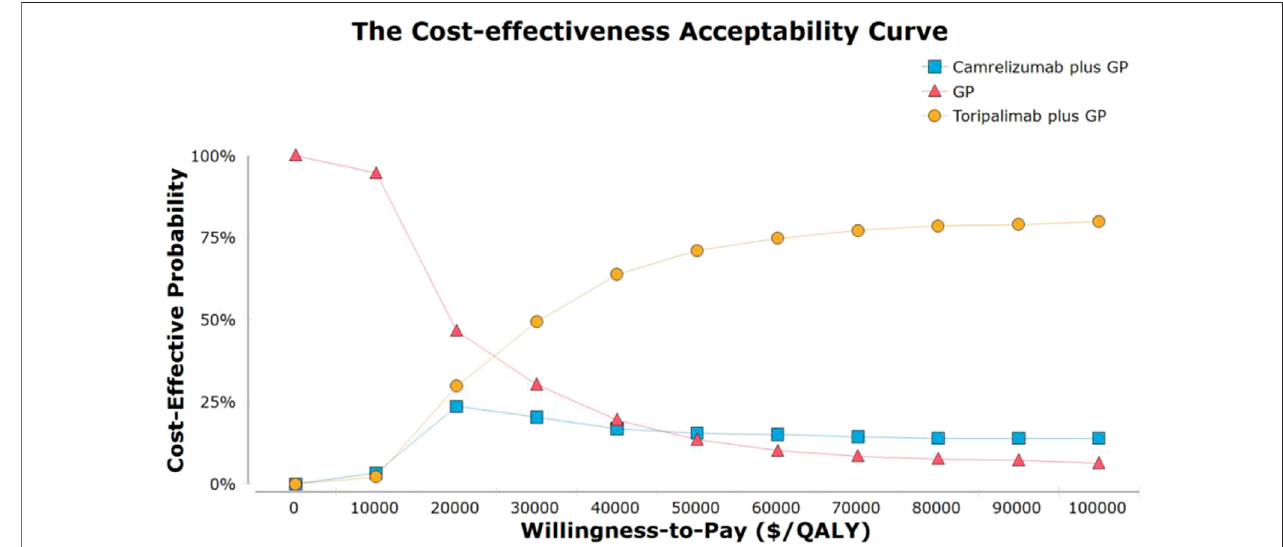
FIGURE 2 | The cost-effectiveness acceptability curves for the toripalimab plus gemcitabine and cisplatin, camrelizumab plus gemcitabine and cisplatin. Abbreviation: GP, gemcitabine plus cisplatin.